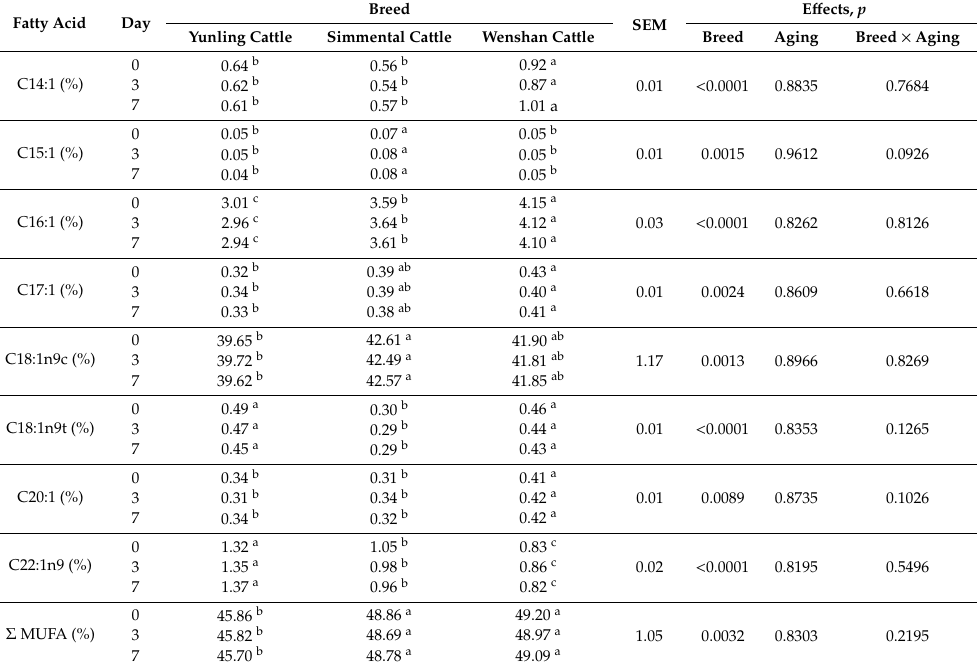
Table 8. The monounsaturated fatty acids content a ff ected by breed and